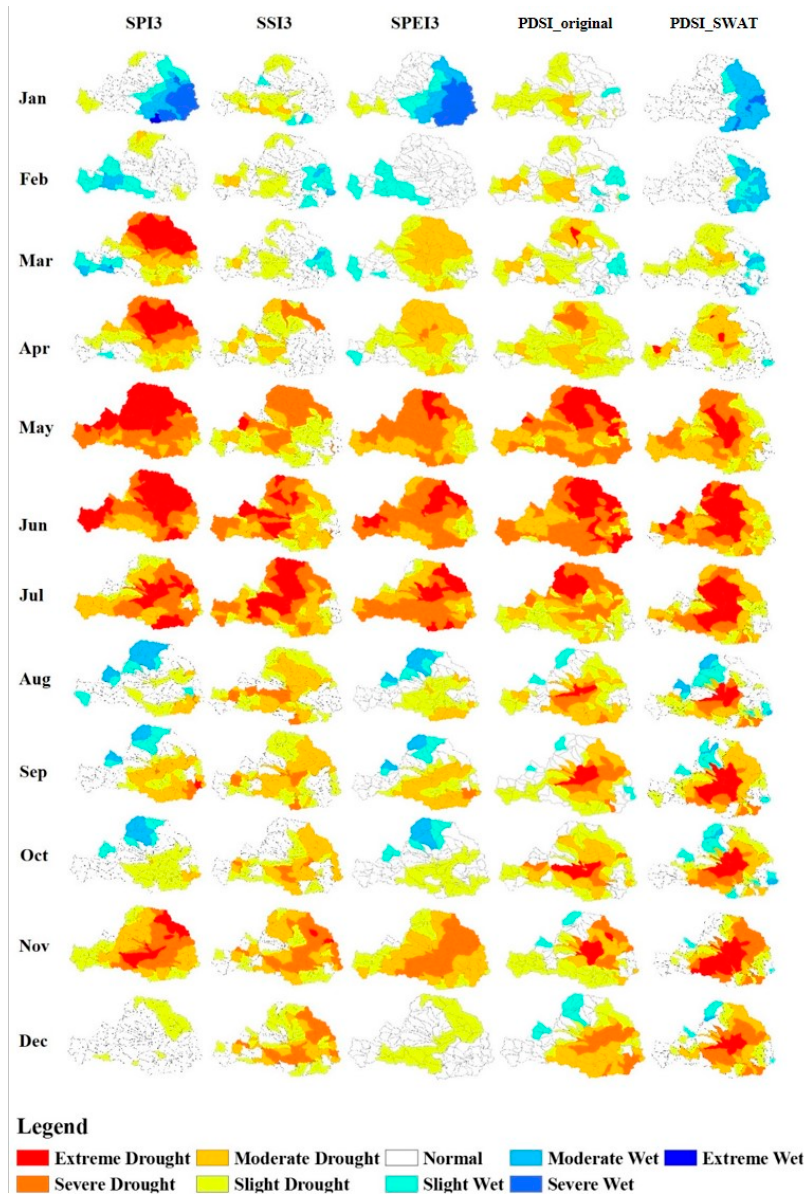
Figure 6. Spatial comparison of the drought by SPI-3, SSI-3, SPEI-3, PDSI and PDSI_SWAT in the WRB in 1995.